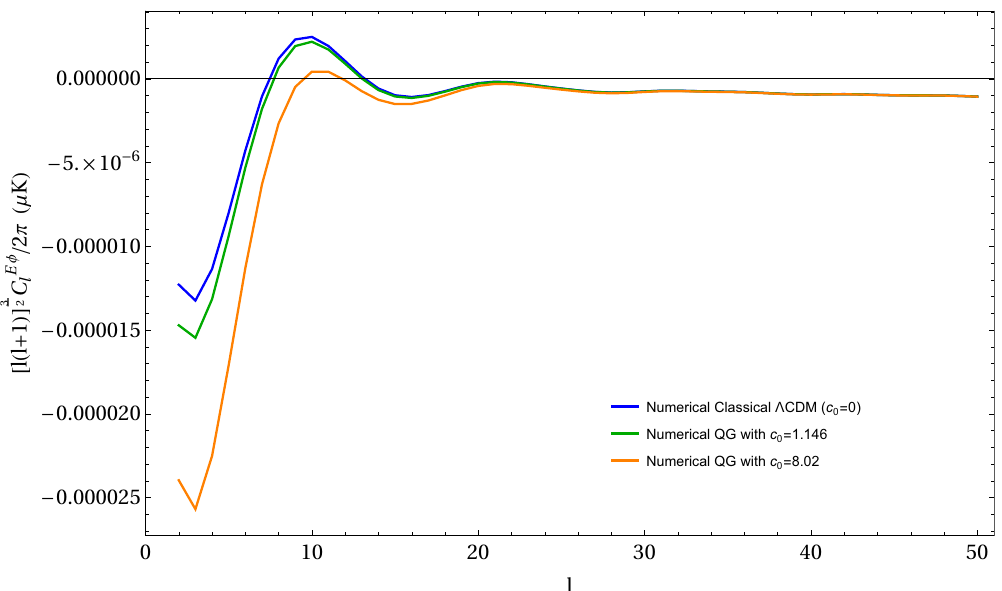
Figure 10. Comparison of the numerical prediction of the classical Λ CDM program vs. numerical predictions of the RG running of Newton’s constant’s effect on the cross-E-mode-lensing (E φ ) power spectrum C E φ . The solid curves represent the numerical predictions generated by ISiTGR, with the l top (blue), middle (green) and bottom (orange) representing quantum amplitudes (see Equation (9)) quantum amplitudes (see Equation (9)) c 0 = 0,1.146,8.02, respectively. showing this time smaller trends at the large angular scales ( l < 20) as compared to the classical no running numerical Λ CDM curve. No data with reasonable errors are found so far for C E φ l